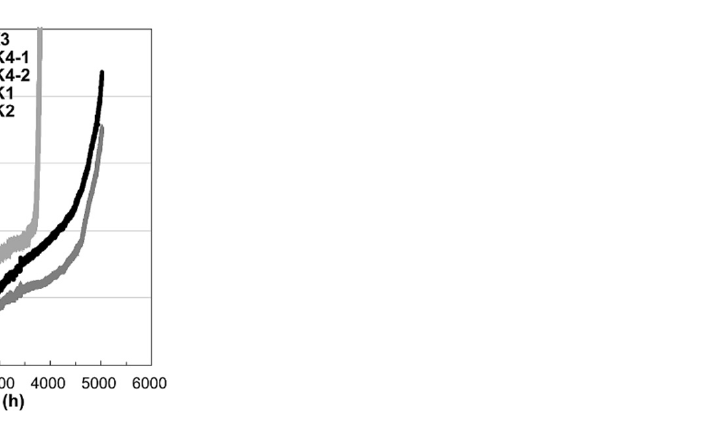
Figure 4. The lifetime of EM test. For the bonding condition 300 ◦ C/90 MPa/30 s, the lifetime is longer than 3500 h. For the bonding condition 300 ◦ C/31 MPa/10 s, the lifetime is longer than 170 h.